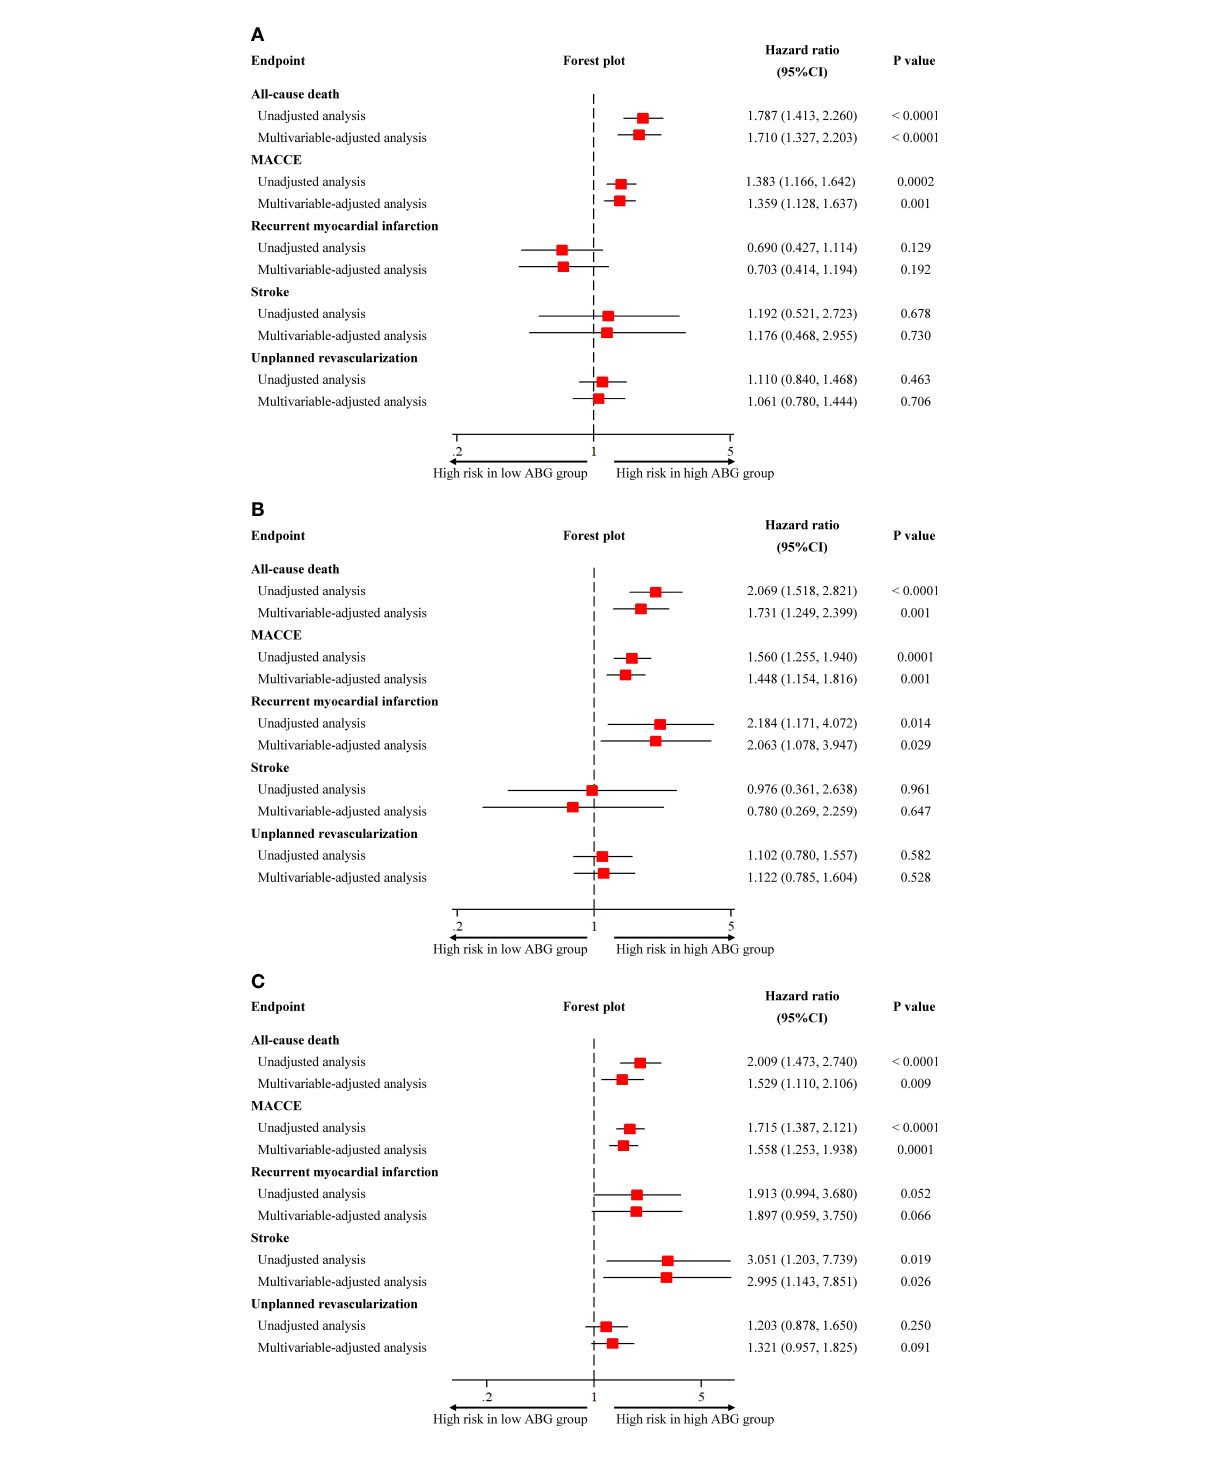
FIGURE 3 | Unadjusted and adjusted association between admission blood glucose and clinical outcomes in patients with different glucose metabolism status. (A) diabetes; (B) pre-diabetes; (C) normal glucose regulation. CI, con fi dence interval; MACCE, major adverse cardiovascular and cerebrovascular